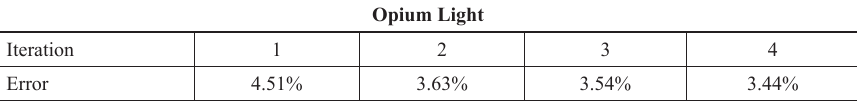
Table 3. Result of Berber-MNIST on OPIUM GPU